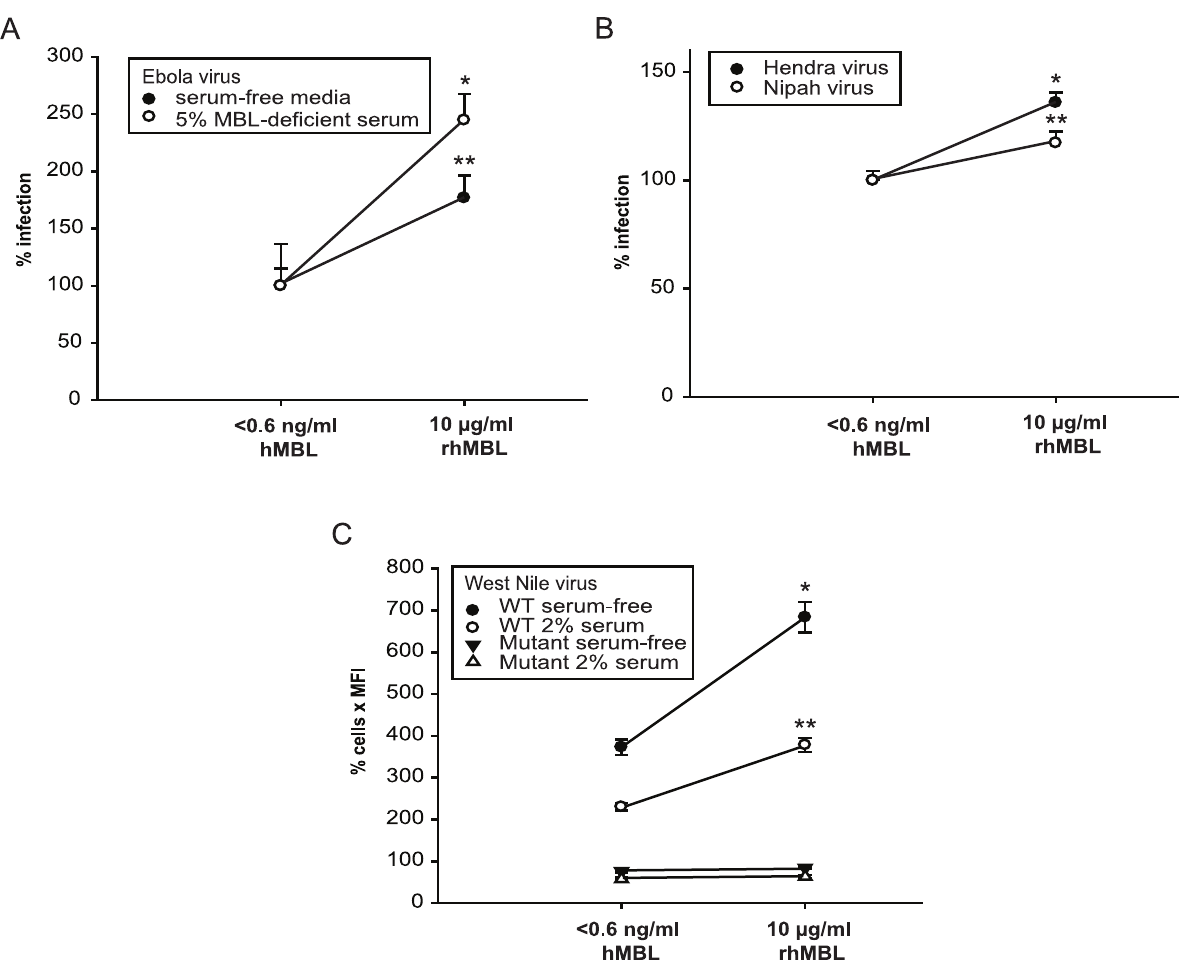
Figure 7. MBL enhances infections by wild type-like EBOV and other glycosylated virions. (A) We preincubated wild type-like EBOV-eGFP (1976 Mayinga variant) with media alone or 5% MBL-deficient serum with or without rhMBL at 37 u C for 1 hour and then infected 4 6 10 4 HEK293T cells (multiplicity of infection, 0.1) at 37 u C for 1 hour. We measured cellular fluorescence after 72 hours of incubation in fresh media. Comparisons are with baseline values, * p=0.028; ** p=0.037. (B) We preincubated native Hendra and Nipah viruses (10,000 TCID 50 /ml) with 10% heat-inactivated MBL- deficient serum with or without rhMBL and then infected Vero E6 cells at 37 u C for 1 hour. After 24 hours, infection was detected by chemiluminescence-based viral protein immunoassays. Comparisons are with baseline values, *p=0.001; ** p=0.029. (C) We preincubated 250 m l West Nile virion-like particle-GFP with media alone or 2% MBL-deficient human serum, with or without rhMBL at 37 u C for 1 hour and then transduced 1 6 10 4 HEK293T cells. Cells were detached using TrypLE and washed three times with PBS at 4 u C. Rates of transduction were assayed by flow cytometry. Comparisons are with baseline values, * p=0.002; ** p=0.001. WT refers to wild type; mutant refers to glycosylation mutant of WNV E protein; hMBL refers to human